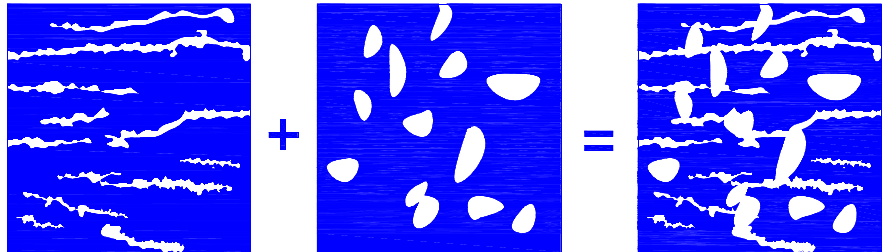
Figure 8. Distributions of the largest pore-fracture cluster and percolating clusters in DCOSs after the superheated steam pyrolysis at different temperatures. For the sake of distinction, the largest pore-fracture cluster is rendered in blue for each DCOS: ( a ) 25 °C; ( b ) 314 °C; ( c ) 382 °C; ( d ) 452 °C; ( e ) 511 °C; ( f ) 534 °C; ( g ) 555 °C.